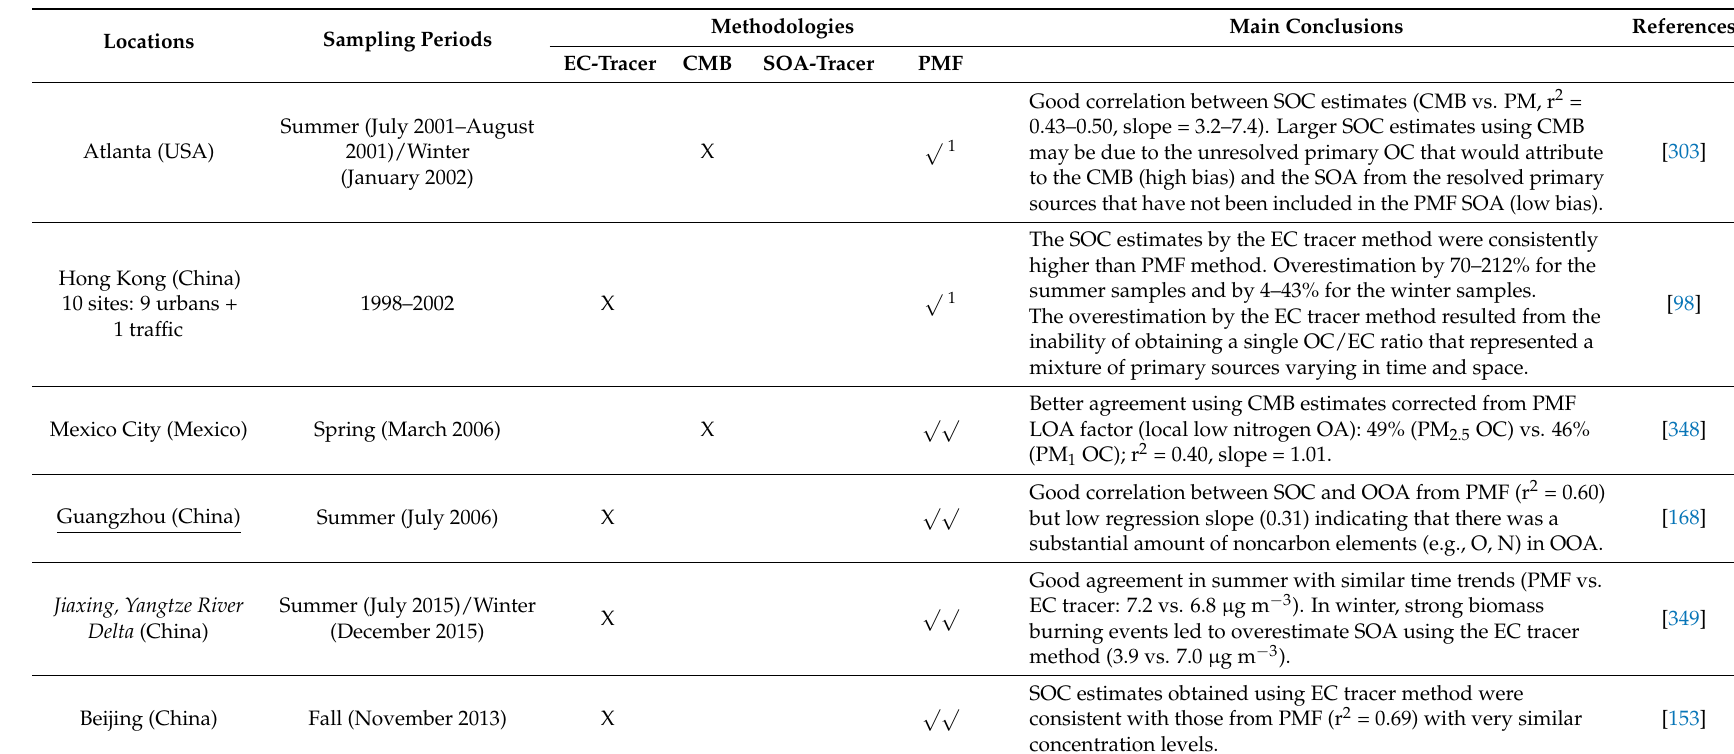
SOC estimates obtained using EC tracer method were consistent with those from PMF (r 2 = 0.69) with very similar concentration